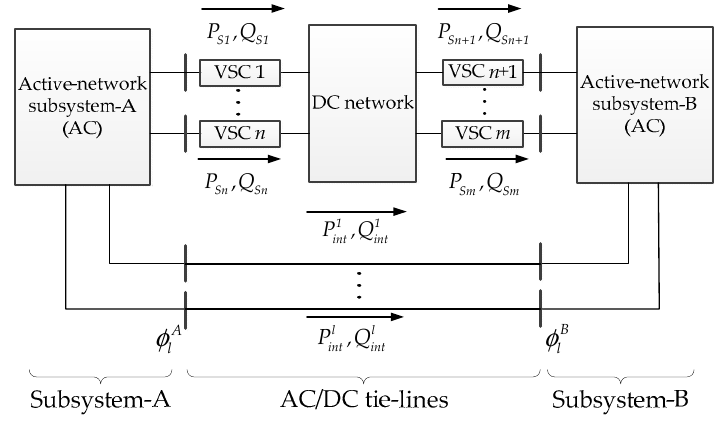
Figure 2. Schematic of multi-area interconnected system.